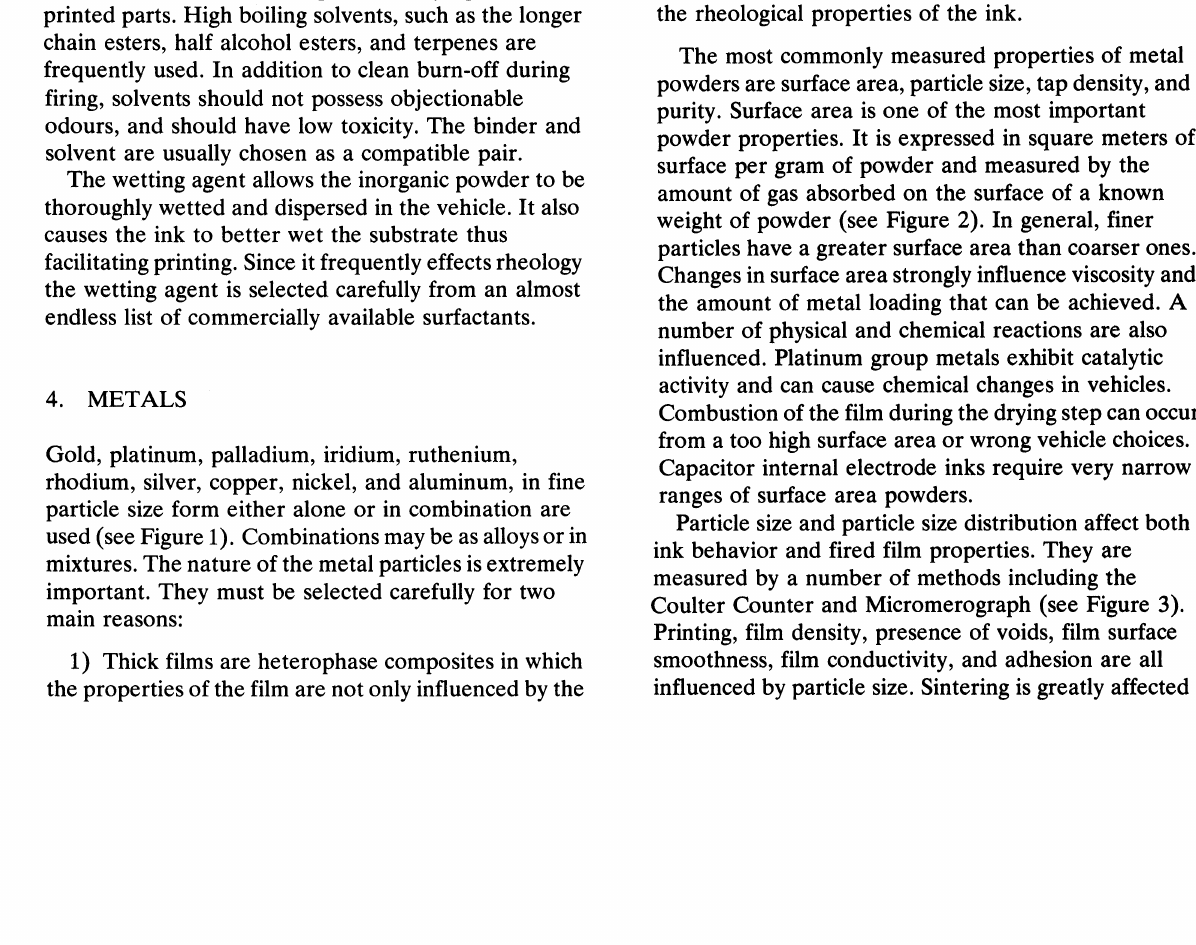
FIGURE Typical metal powders for thick film